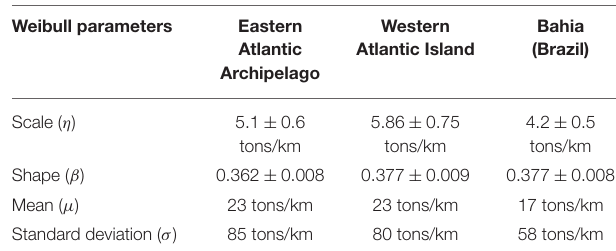
TABLE 3 | Weibull distribution parameters emerging from the maximum likelihood